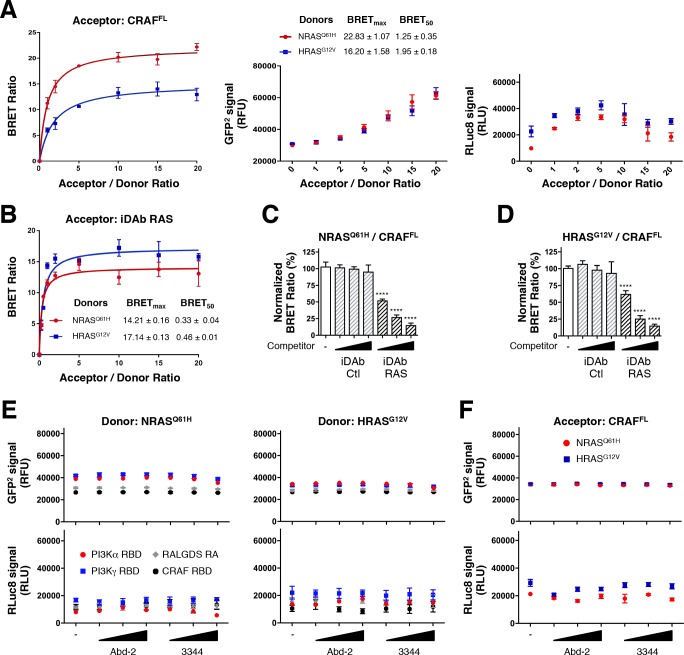
iDAb RAS inhibits mutant NRAS and HRAS interaction with CRAFFL.(A) BRET titration curves of NRASQ61H and HRASG12V with CRAFFL with total GFP2 and RLuc8 controls. (B) BRET titration curves of NRASQ61H and HRASG12V with iDAb RAS. (C, D) Competition assays show the inhibition of NRASQ61H/CRAFFL interaction (C) and HRASG12V/CRAFFL interaction (D) by iDAb RAS (black striped bars) in a dose-dependent manner compared to the non-relevant iDAb control (grey striped bars) and the no competitor control (-, white bar). (E, F) Total GFP2 and RLuc8 levels from the BRET competition assay shown in Figure 5A–D. Statistical analyses in C and D were performed using a one-way ANOVA followed by Dunnett’s post-hoc tests (****p<0.0001). Each experiment was repeated twice (A, B) or four times (C, D). Where error bars are presented, they correspond to mean values ± SD biological repeats.